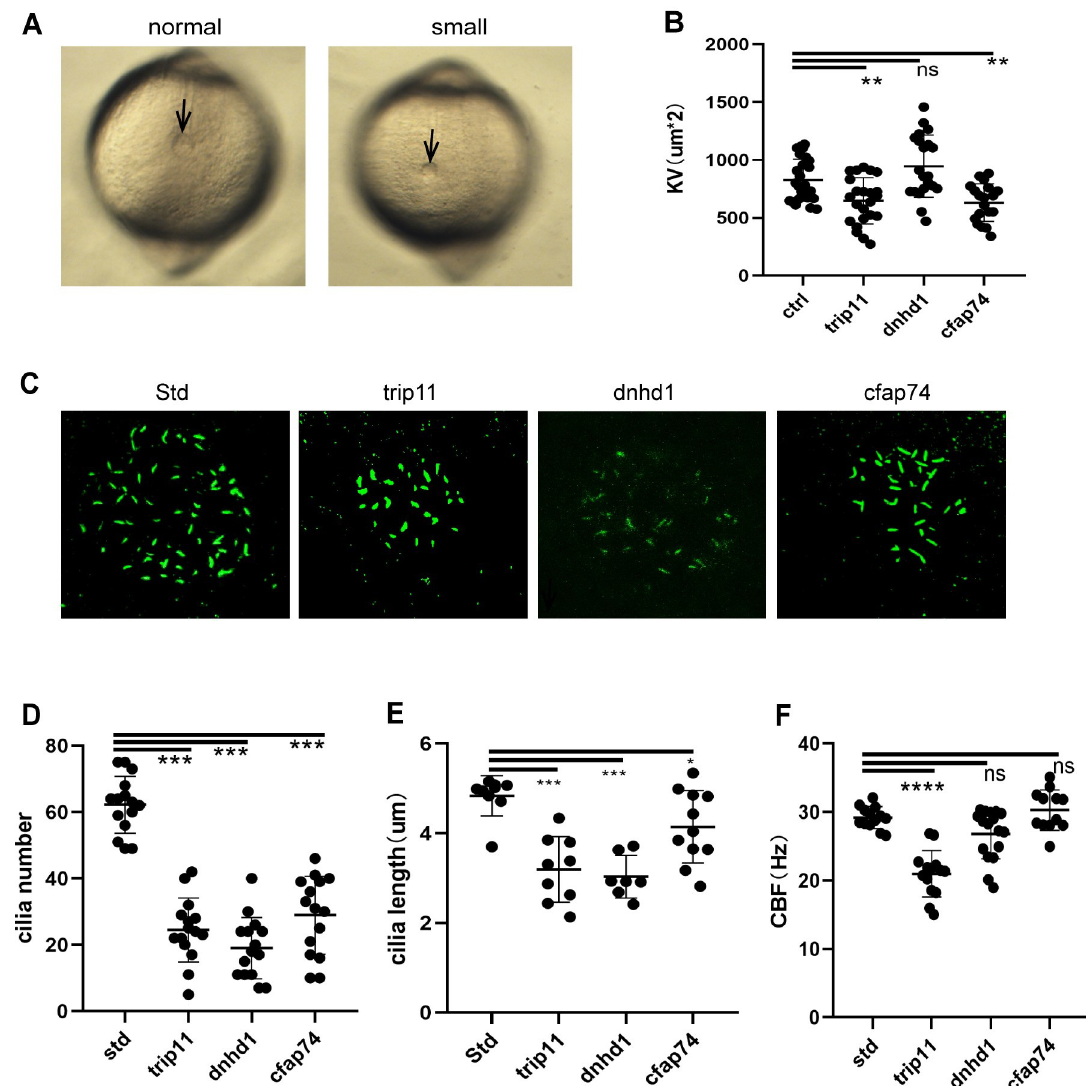
Fig 5. Candidate genes are required for KV formation and ciliogenesis. (A) The light-micro graph at the 8-somite stage showed different KV sizes, including normal and small. (B) The vesicle size of KV apical area. N � 19. (C) Fluorescent immunostaining of cilia in KV using anti- α -Tubulin antibodies at the 12hpf. (D) LRO Cilia number per KV was quantified and the group values were expressed as the mean ± SD. N � 15. (E) The average length of LRO Cilia per KV was quantified and the group values were expressed as the mean ± SD. N � 7. (F) The ciliary beat frequency (CBF). N � 12. Statistical significance was determined by Mann Whitney test; � P < 0.05, ��� P < 0.001, respectively vs.